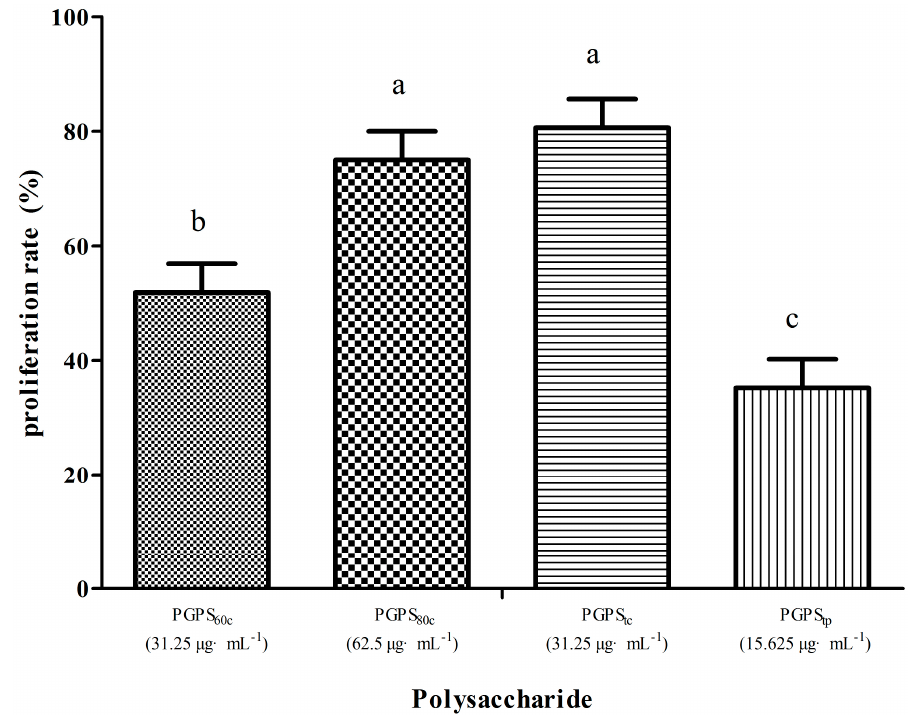
Figure 1. The highest lymphocyte proliferation rate of each group in single stimulation with PGPSs. The values are presented as means ± SE ( n = 4). a–c Bars without the same superscripts differ significantly ( p < 0.05).